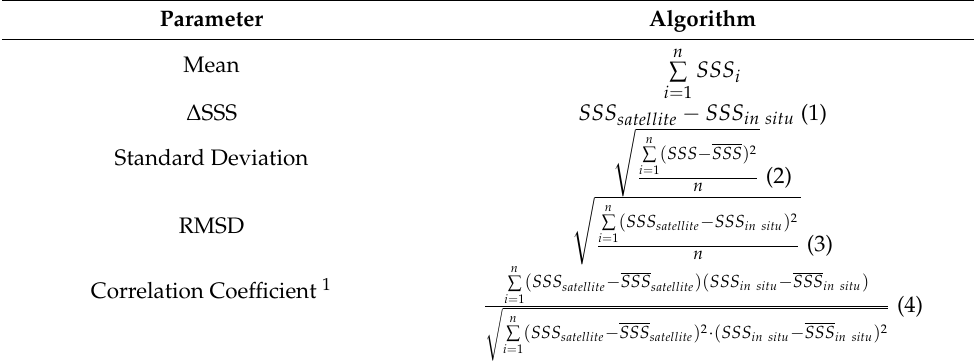
Table 1. Specific algorithm for the fundamental statistic parameters used in this study. Parameter